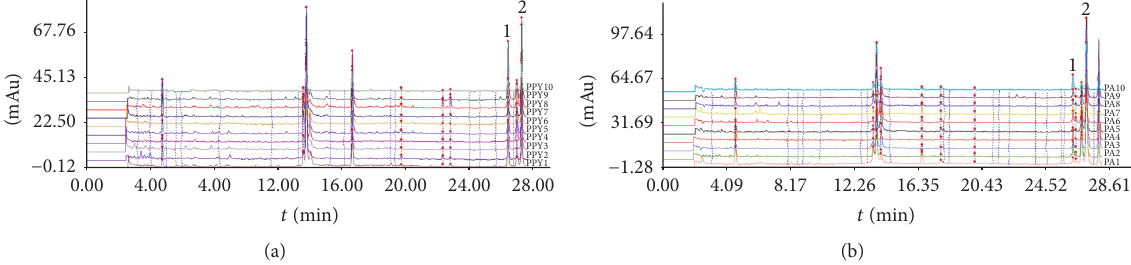
Figure 7: (a) UHPLC chromatograms fingerprint for PPY. (b) UHPLC chromatograms fingerprint for PA. Marked “1 and 2” are the represented polyphyllin II and polyphyllin